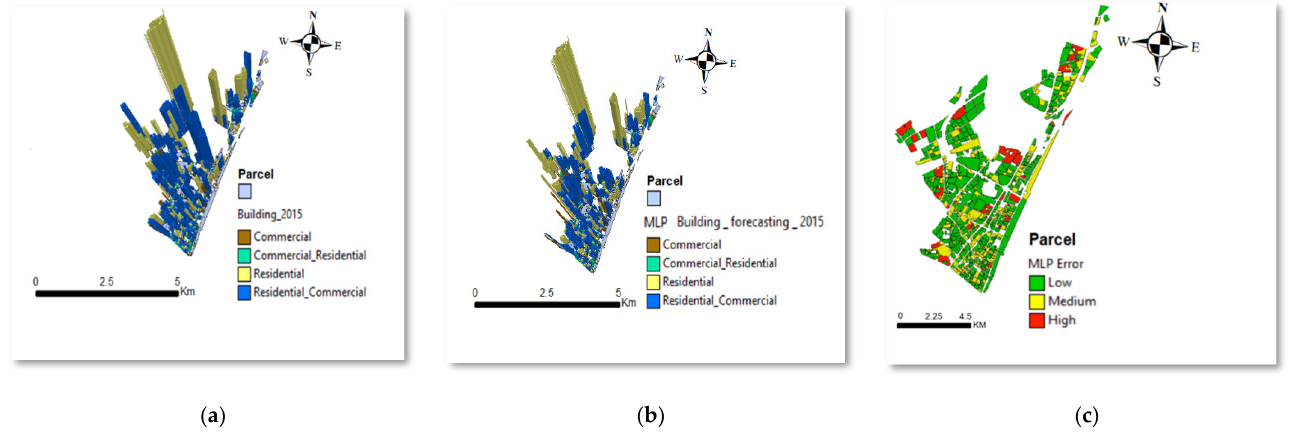
Figure 13. ( a – c ) The predicted results from the MLP model and the difference between the observed and predicted building quantities at the parcels level: ( a ) building type at parcel level 2015 (observed); ( b ) MLP model prediction; and ( c ) difference error between actual building types 2015 and MLP model prediction.